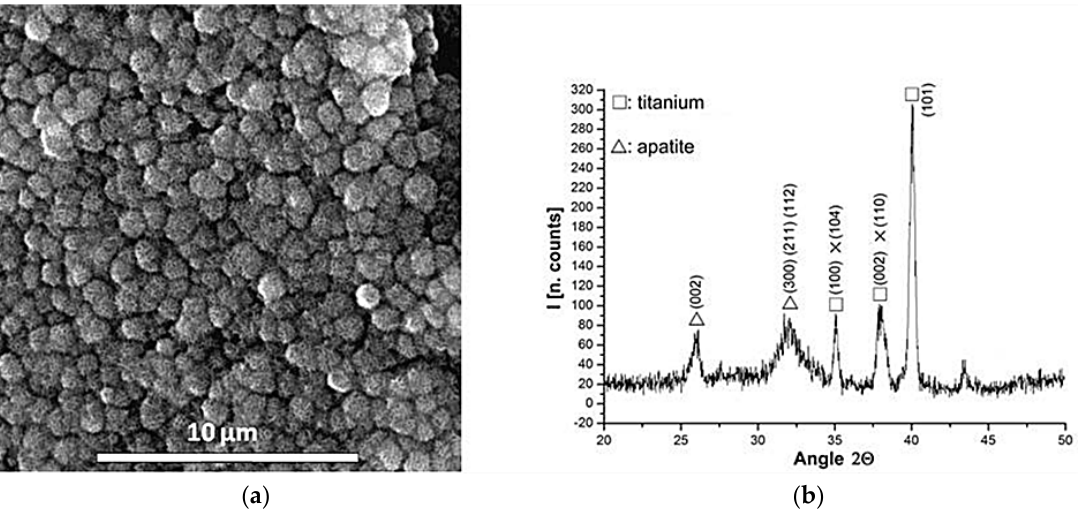
Figure 3. ( a ) SEM micrograph of apatite layer on NiTi surface (Alloy A) after soaked in SBF for three days; and ( b ) GI-XRD pattern showing peaks corresponding to the apatite crystals (32° and 26°).